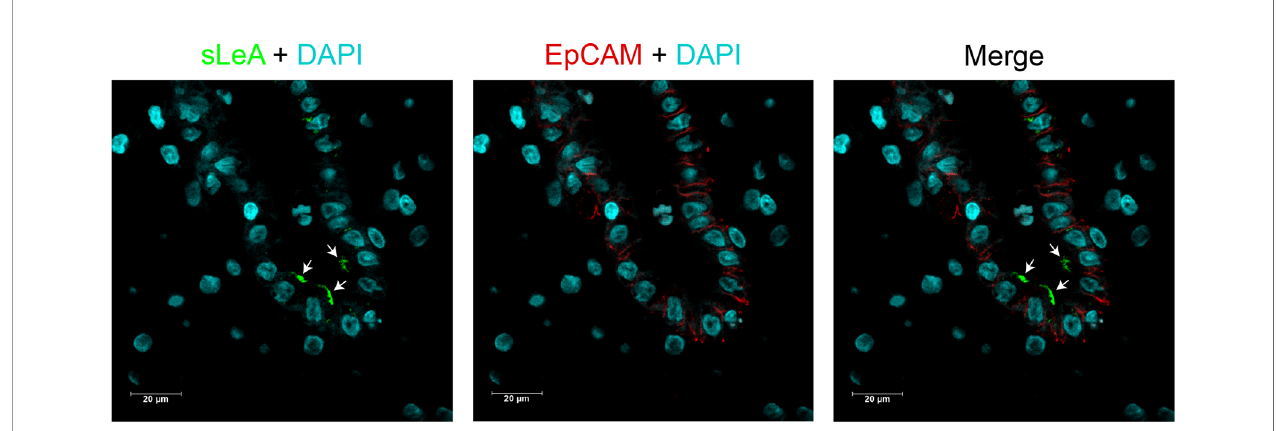
FIGURE 2 | Cellular localization of sLeA in epithelial cells of placenta tissue. sLeA (green) and epithelial cell marker EpCAM (red) were double stained, the confocal images show that sLeA localizes at the apical membrane of epithelial cells as white arrows indicate.